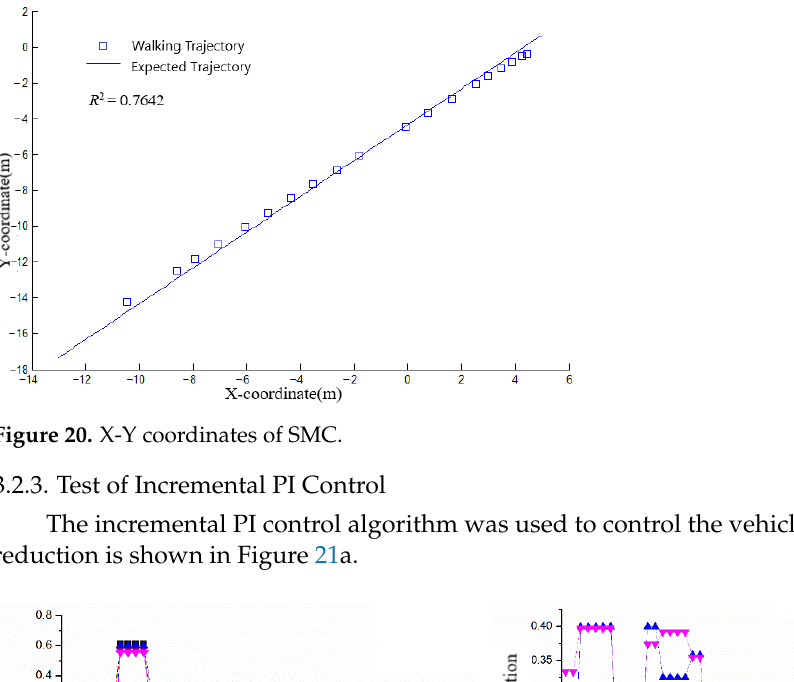
Figure 19. Travel reduction of and coefficient of gross traction SMC. ( a ) Travel reduction; ( b ) Coef- ficient of gross traction.